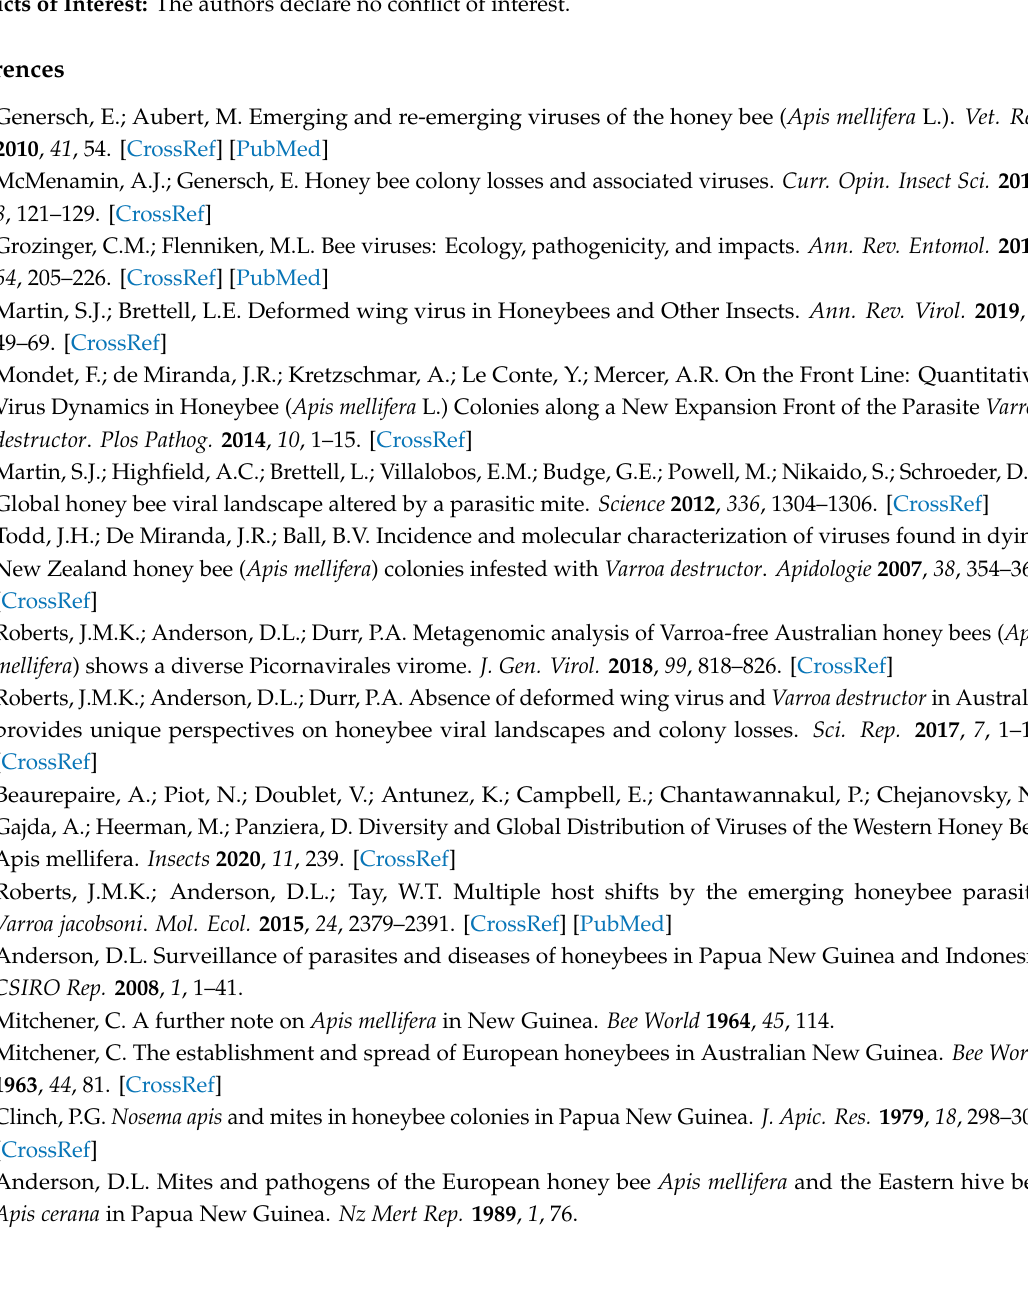
Table S1. Collection information of honey bee and Varroa mite samples used in this